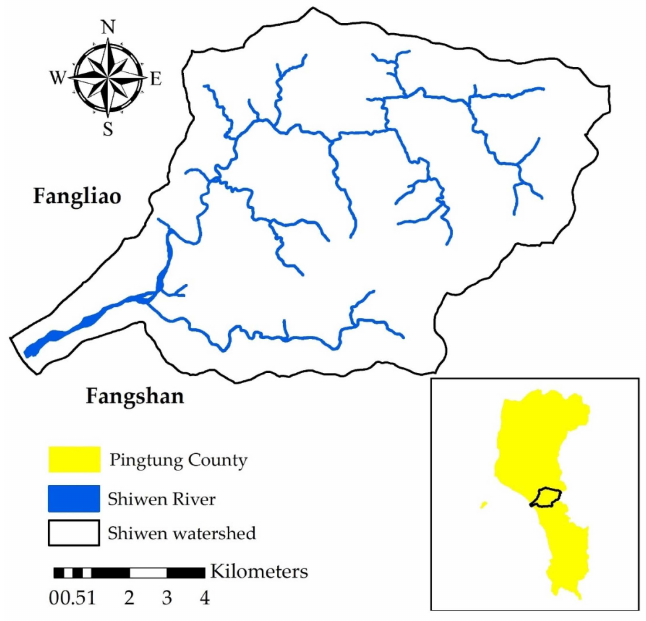
Figure 1. Shiwen River watershed.